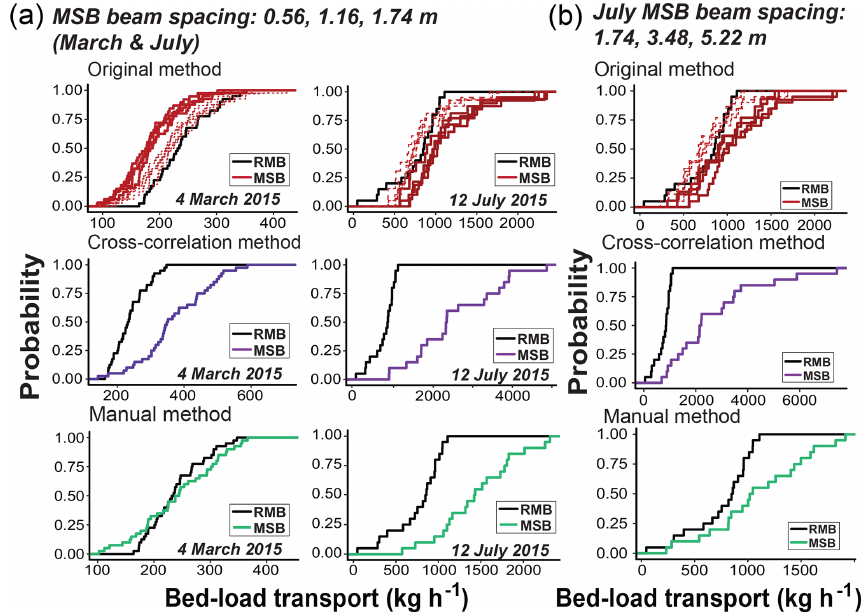
Figure 4. CDFs of lag-corrected repeat multibeam (RMB; black) and multiple single-beam (MSB) bed-load transport estimates using the original (red), cross-correlation (purple), and manual methods (green) to calculate bedform celerity for the multiple single-beam profiles. Dashed red lines are sine-corrected estimates. (a) Multiple single-beam beam spacing of 0–0.56–1.16–1.74m for both March and July.